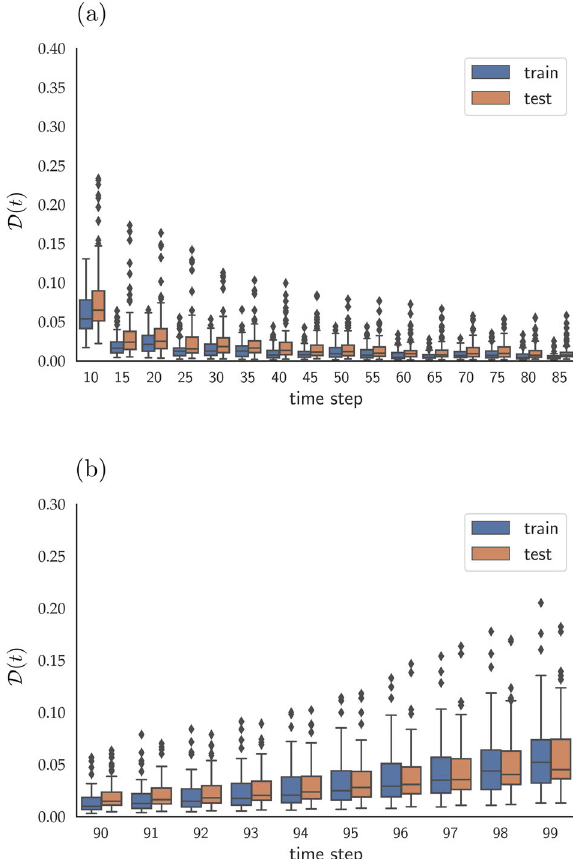
Fig. 3 L 2 norm of the relative error between true and predicted microstructures at each time step. a Box plot with respect to D ð t Þ computed over the training time steps over the train and test datasets. Error bars are equivalent throughout the fi gure. b Same error metric, but in future time steps never seen during the training phase. Error bars are equivalent throughout the fi gure.